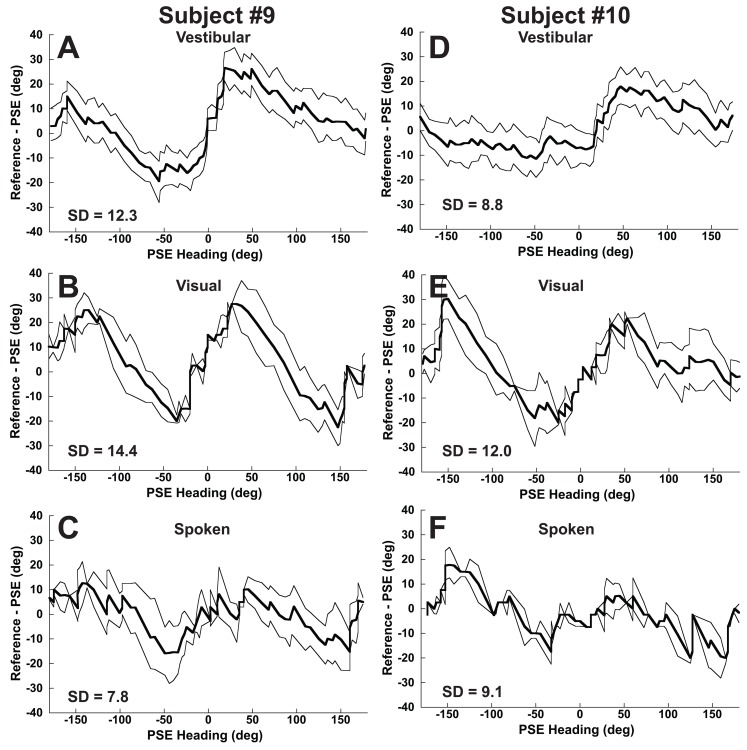
Direction specific bias for two subjects (#9 and #10) for three stimulus conditions.These plots are analogous to Fig. 4A–C, but are for specific subjects rather than the whole population. The thick line represents the mean value, and the two thin lines represent the 95% CI based on 100 fits with resampling of the data with each iteration. Panels A and D: Vestibular motion. Panels B and E: Visual motion (optic flow). Panels C and F: The subject orients a dial based on a spoken heading.